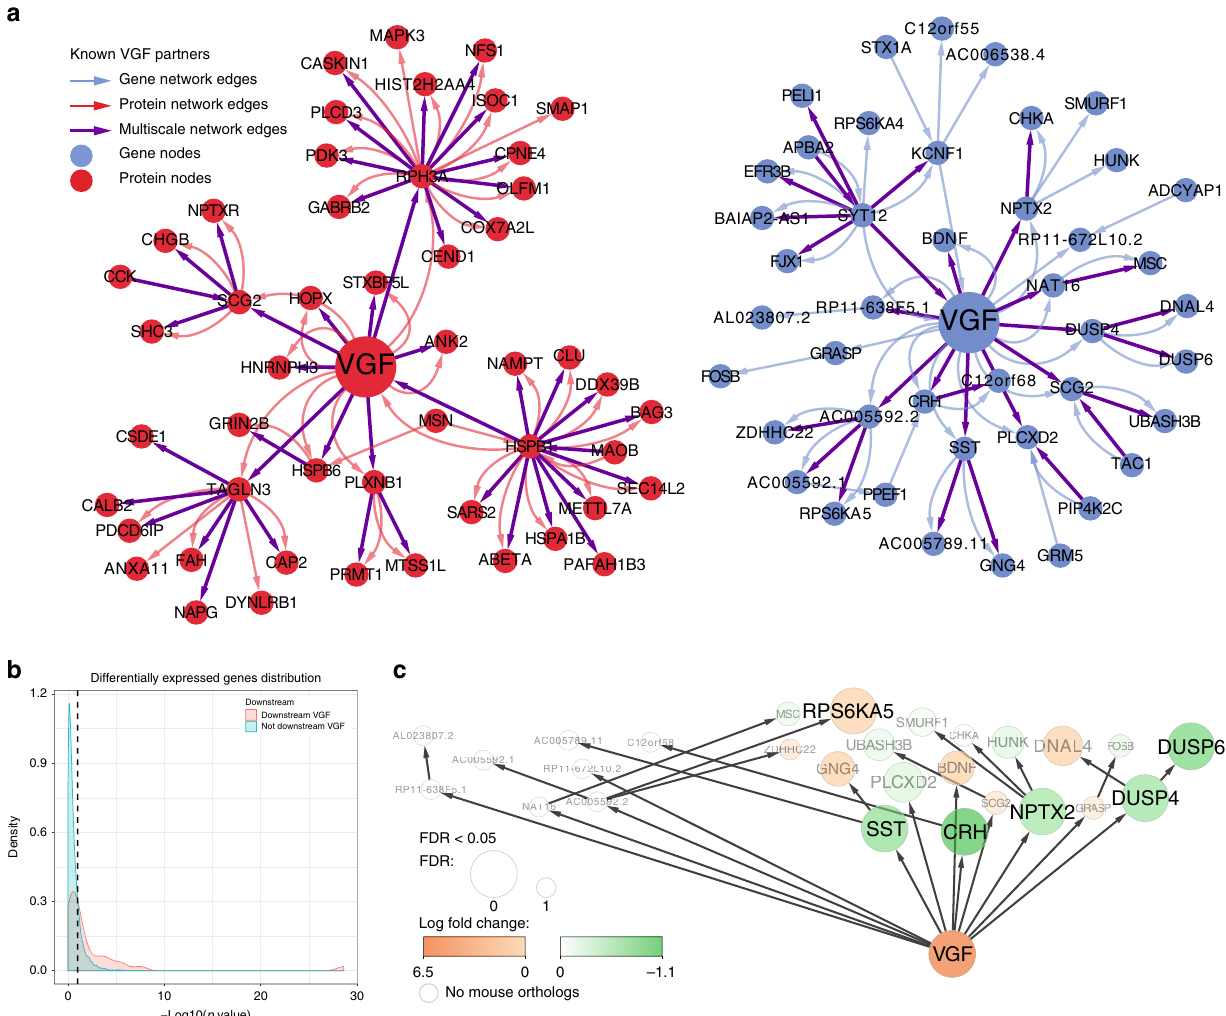
Fig. 8 Molecular validation of VGF. a Consensus subnetwork within a path length of 2 of VGF. The consensus subnetworks around VGF, two steps away from VGF, across all three networks are depicted. The blue and red nodes are genes and proteins, respectively. The blue edges originate from the gene-only network, the red edges from the protein only network, and the purple edges from the multiscale network. VGF and its known partners are in bold in the plot. b Density plot of the distribution of differential expression nominal p values for genes downstream and not downstream (causally independent of the expression levels) of VGF in the gene-only network for mouse DE genes (5xFAD, AAV5-GFP versus 5xFAD, AAV5-VGF brains). The x -axis is the − log 10 ( p value) for differential expression, and the y-axis represents the densities at the different − log10( p value). The red and blue curves are for genes downstream and not downstream of VGF in the network, respectively. c Summary of DE results of VGF network genes in the 5xFAD, AAV5-GFP versus 5xFAD, AAV5-VGF brains overlaid on the VGF gene-only subnetwork. The nodes are colored by log fold change from green (negative) to orange (positive). The size of the node represents the DE FDR. Gray genes names are not signi fi cantly DE and white nodes have no orthologous genes in